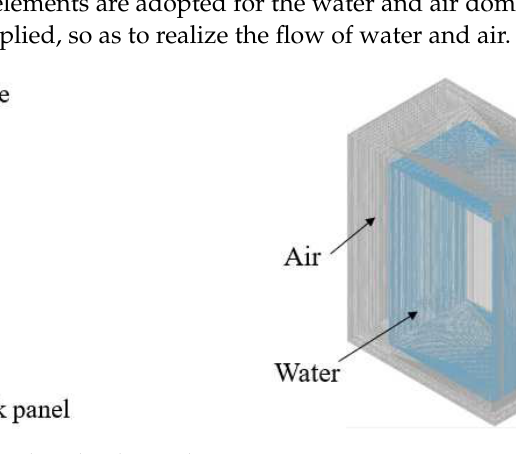
Figure 4. Numerical model of water tank and Eulerian domains.